Question: Based on the figure, does the quantity rise or fall?
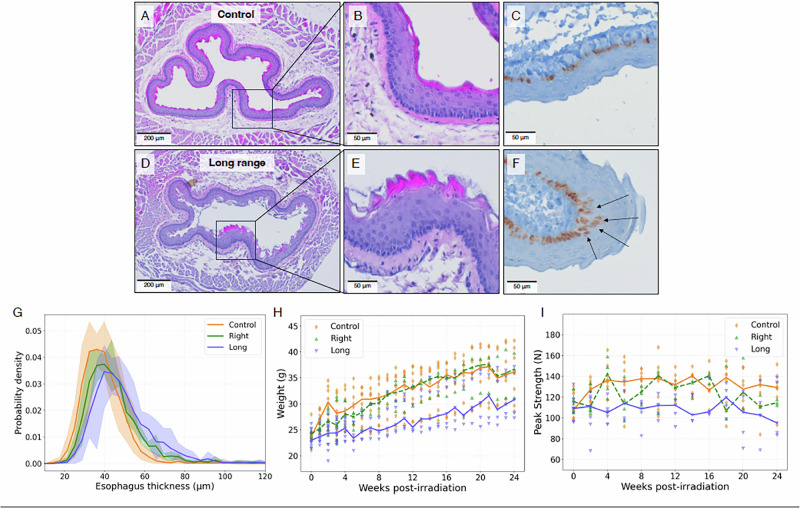
Answer: increasing